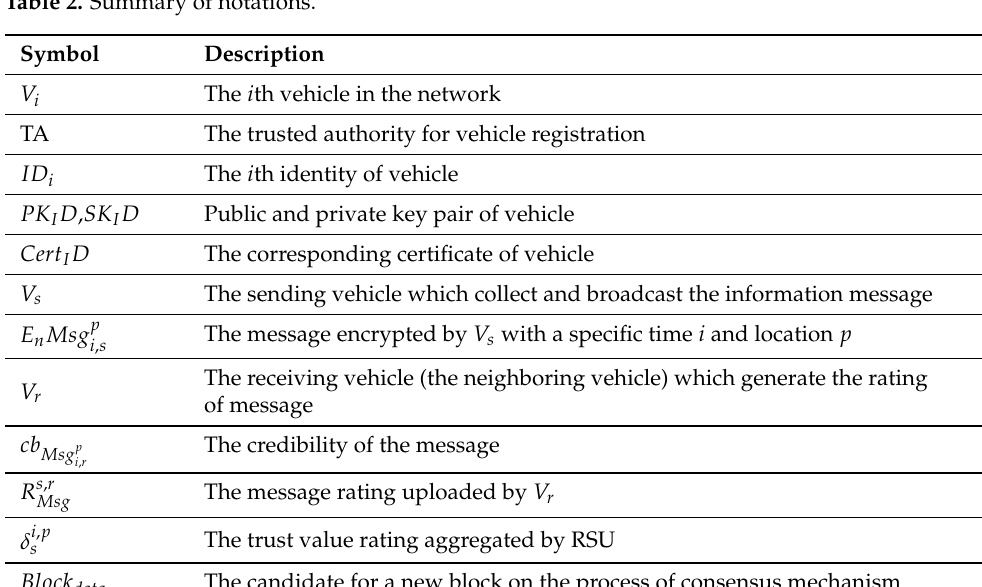
Figure 2. Procedures of proposed architecture. Table 2. Summary of